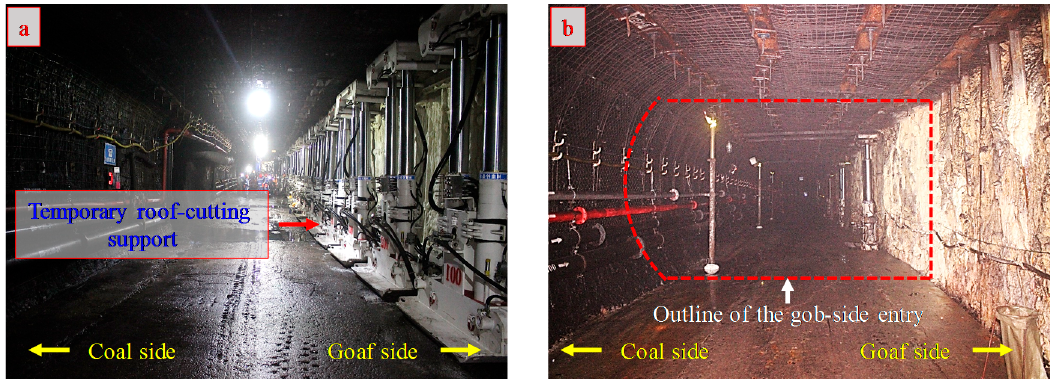
Figure 17. Final entry retaining effects. ( a ) Before temporary support is withdrawn; ( b ) Temporary support has been withdrawn.